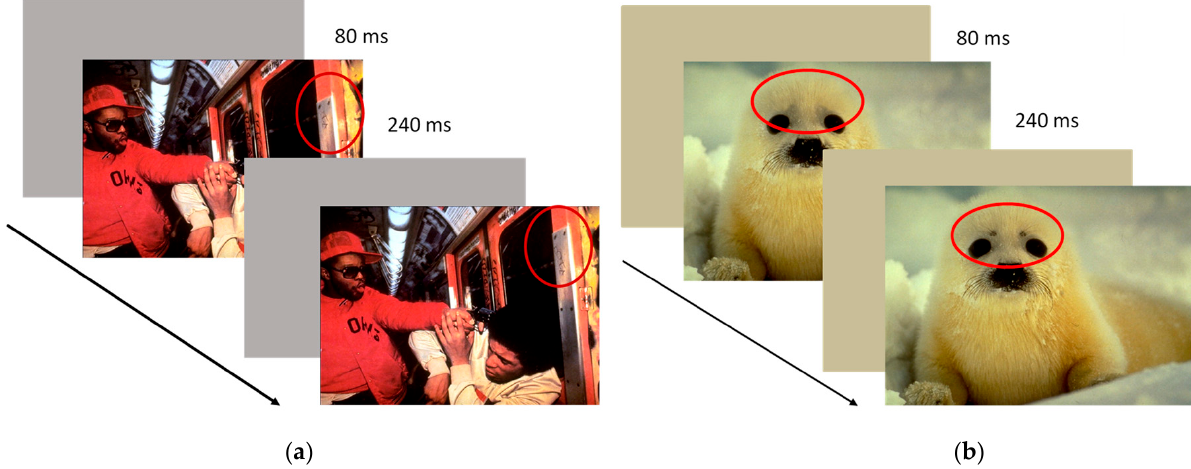
Figure 1. Examples of flicker task trials. ( a ) Marginal interest change in negative scene. ( b ) Central interest change in positive scene.